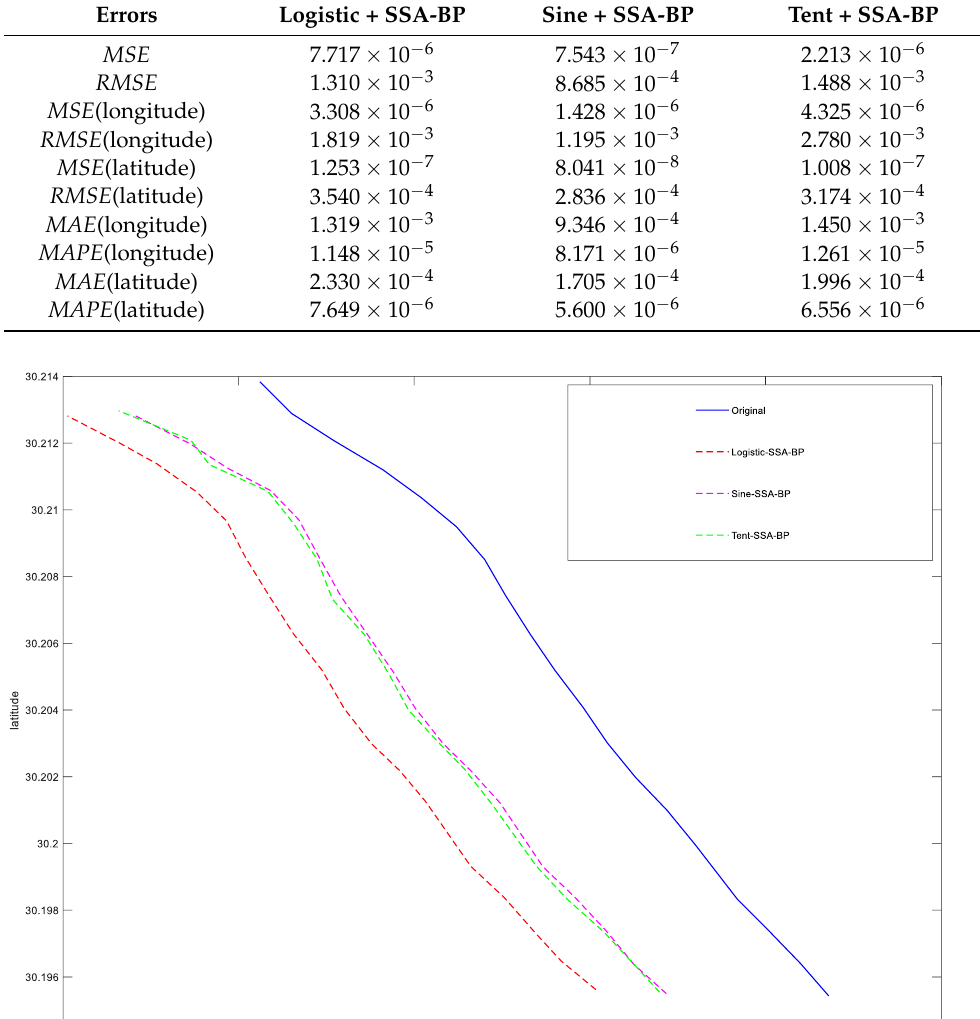
Table 1. Comparison of SSA-BP models of different structures.